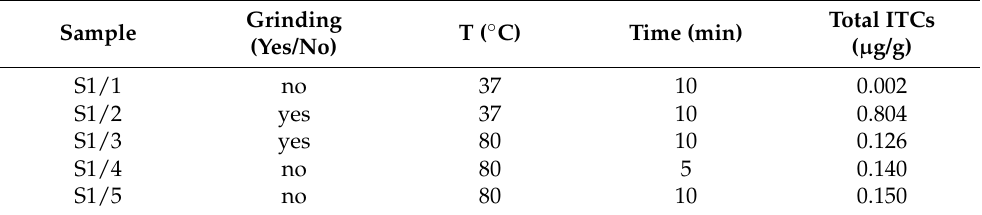
Table 1. Effects of meshing, temperature and time on release of isothiocyanates (ITCs) from fresh flowers of SO (S1) in